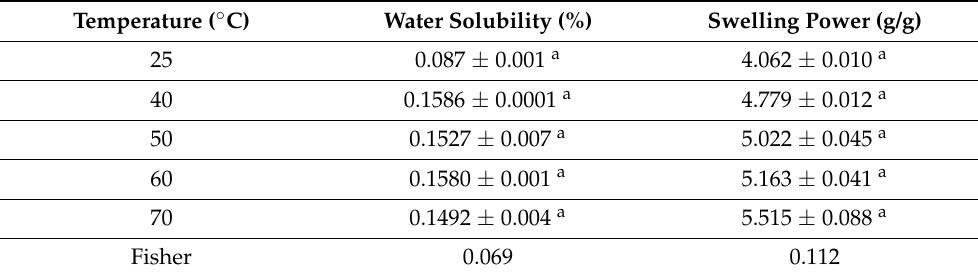
Table 6. Water solubility and swelling power of jackfruit seed flour evaluated at different temperatures. Temperature ( ◦ C) Water Solubility (%) Swelling Power (g/g) 25 0.087 ± 0.001 a 4.062 ± 0.010 a 40 0.1586 ± 0.0001 a 4.779 ± 0.012 a 50 0.1527 ± 0.007 a 60 0.1580 ± 0.001 a 70 Fisher 0.069